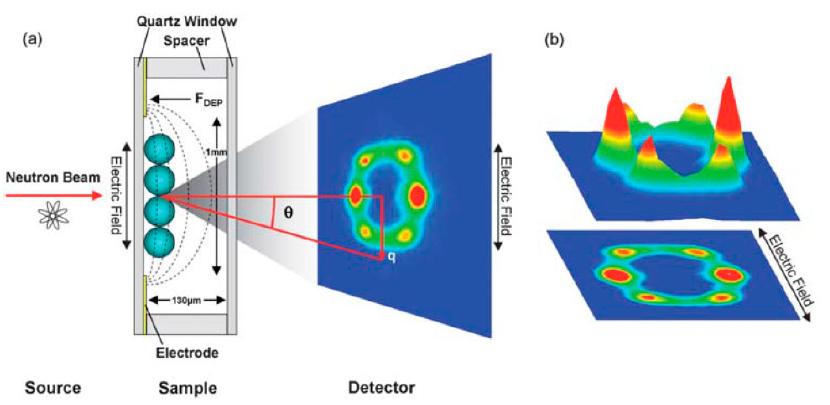
Figure 11. Top view of an electrophoresis cell used for on-line SANS experiments (panel ( a )). The AC field is applied perpendicular to the beam direction and induces the formation of a colloidal crystal. Panel ( b ) shows a representative diffraction result. Figures not to scale (reproduced with permission from [90], The Royal Society of Chemistry, 2010).